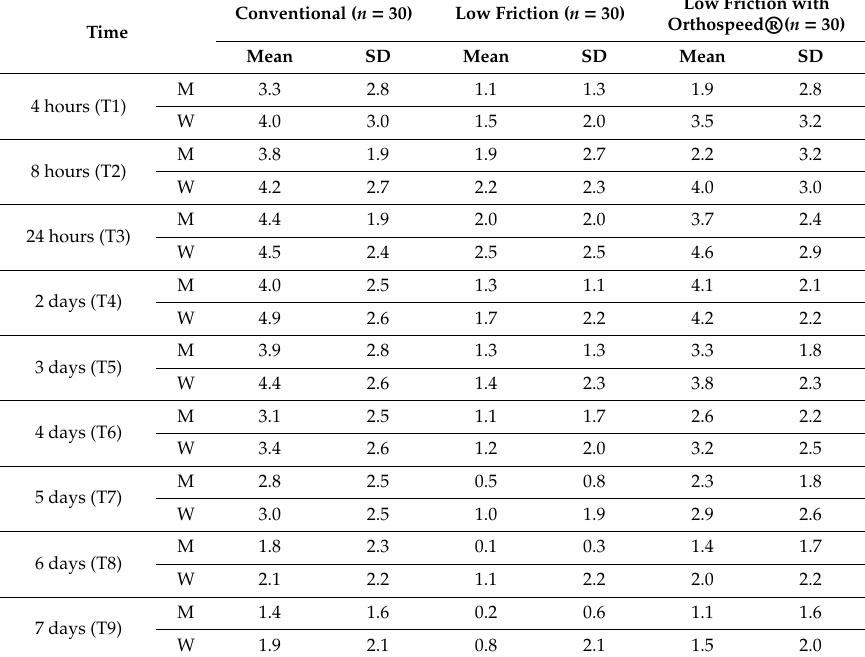
Table 3. Comparison of pain among the di ff erent assessment time points and according to gender using the visual analogue scale and the Student’s t